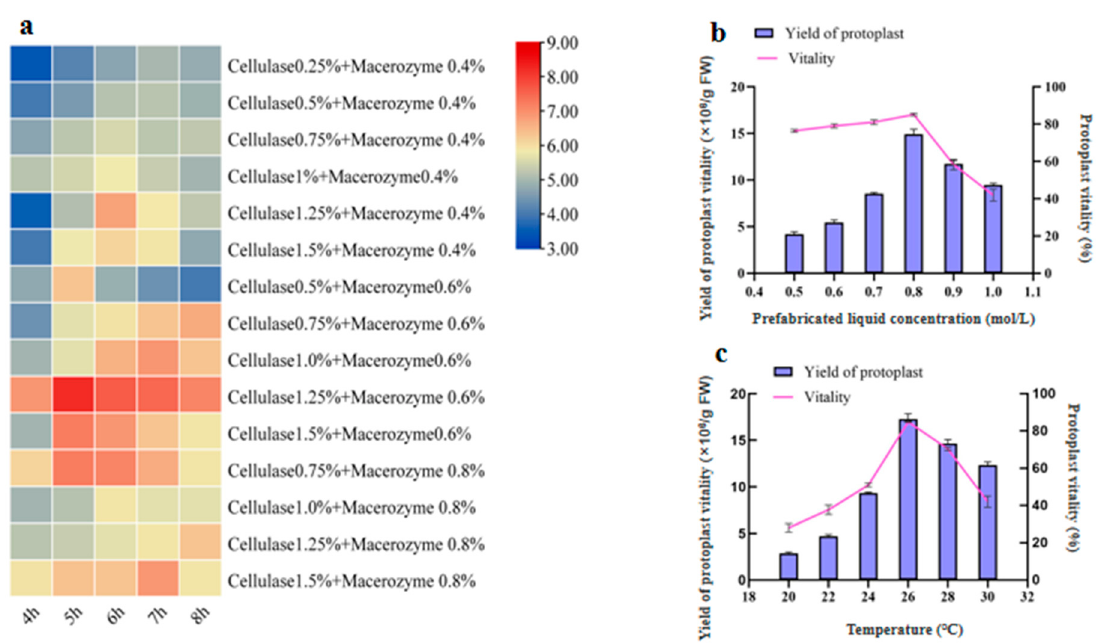
Figure 2. Factors influencing the isolation of U. rhynchophylla protoplasts. ( a ) The heatmap of U. rhynchophylla protoplast yield under different enzyme concentrations and digestion times, the darker the red color, the higher the yield of protoplasts. ( b ) Effect of different D-mannitol concentrations on the yield and viability of U. rhynchophylla protoplasts. ( c ) Effects of different temperatures on the yield and viability of U. rhynchophylla protoplasts.